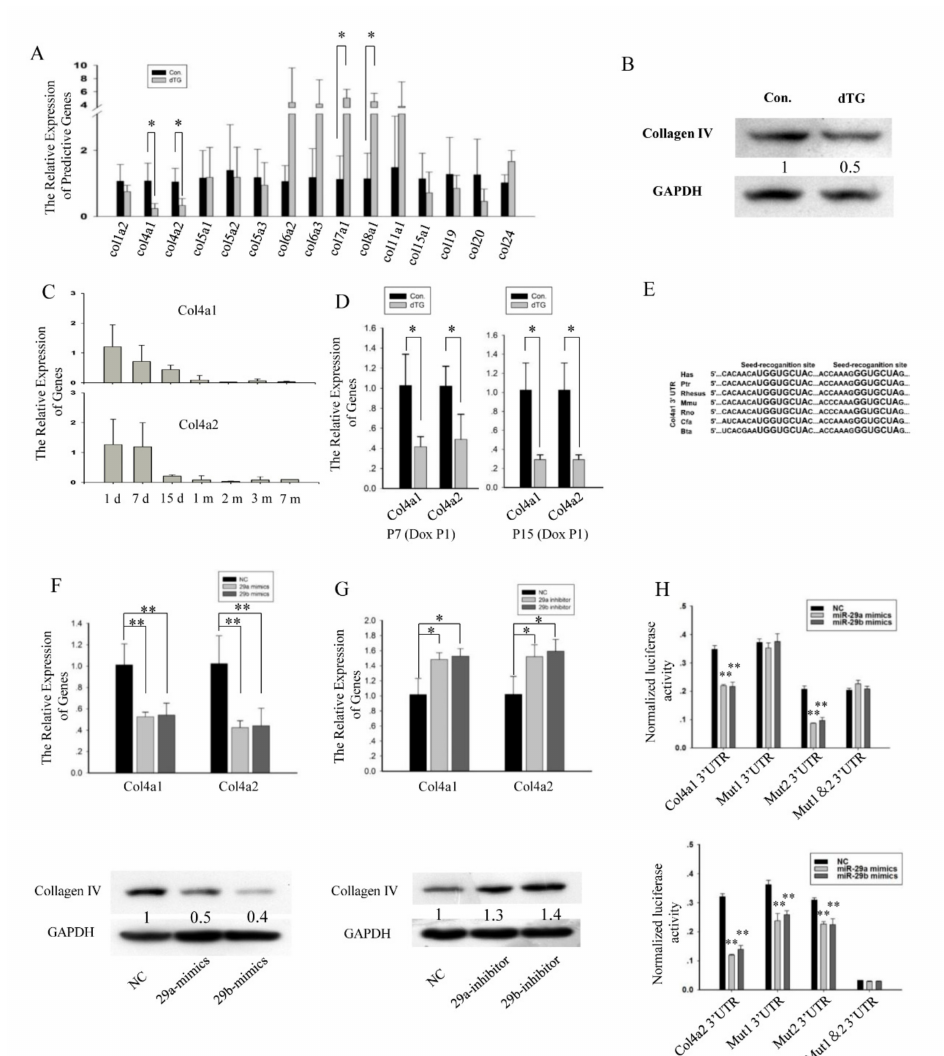
Figure 5. Col4a1 and Col4a2 are the direct target genes of miR-29. ( A ) Expression analysis of miR-29 target genes related to collagen in the tibialis anterior muscles. The values represent the mean ± SEM (n = 3). *, p < 0.05. ( B ) Western blot showing the decrease in Col4 protein level in the dTG mice. GAPDH was used as an internal normalized reference. ( C ) The relative expression levels of Col4a1 and Col4a2 in the tibialis anterior muscles of mice at di ff erent ages were analyzed by Q-PCR. The values represent the mean ± SEM (n = 3). d, day(s); m, month(s). ( D ) Expression analysis of Col4a1 and Col4a2 in the tibialis anterior muscles. *, p < 0.05. ( E ) The binding sites in the Col4a1 3 (cid:48) UTR are indicated in bold, and all nucleotides in the binding sites are conserved across several species. Hsa, Homo sapiens; Ptr, Pan troglodytes; Rhesus, Macaca mulatta; Mmu, Mus musculus; Rno, Rattus norvegicus; Cfa, Canis lupus familiaris; Bta, Bos Taurus. ( F ) Expression analysis of genes related to protein degradation in the tibialis anterior muscles. *, p < 0.05; **, p < 0.01. (F) Expression analysis of Col4a1 and Col4a2 in C2C12 cells transfected with miR-29 mimics or negative control (NC). The values represent the mean ± SEM (n = 3). **, p < 0.01. ( G ) Expression analysis of Col4a1 and Col4a2 in C2C12 cells transfected with miR-29 inhibitor or INC (n = 3). *, p < 0.05. ( H ) miR-29 mimics influenced the relative luciferases activity of the Col4a1 , mutant (Mut) Col4a1 , Col4a2 , and mutant Col4a2 vectors. **, p <